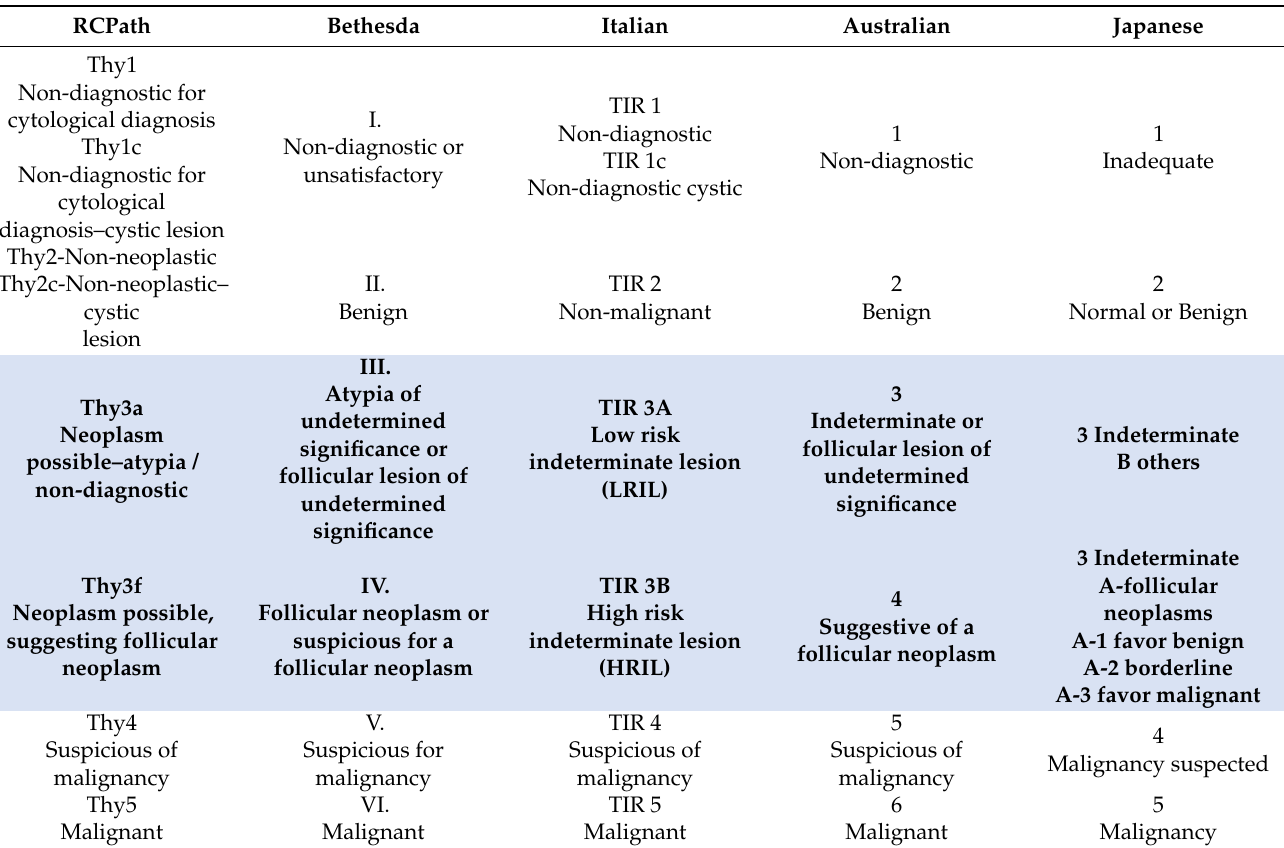
Table 1. Classification schemes for reporting thyroid cytology. Indeterminate diagnostic categories are